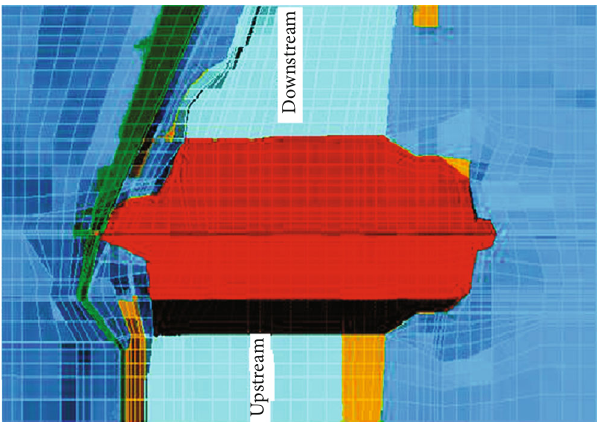
Figure 6: The schematic diagram of a boundary condition.